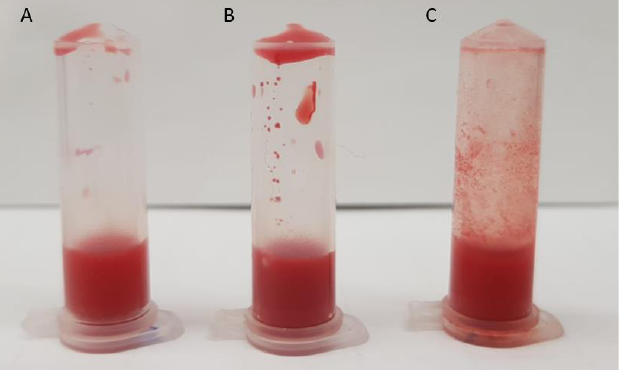
Figure 4. Ex vivo blood – liposome interaction. Blood from non-treated mice was mixed with either ( A ) PBS, ( B ) neutral, or ( C ) cationic liposomes.